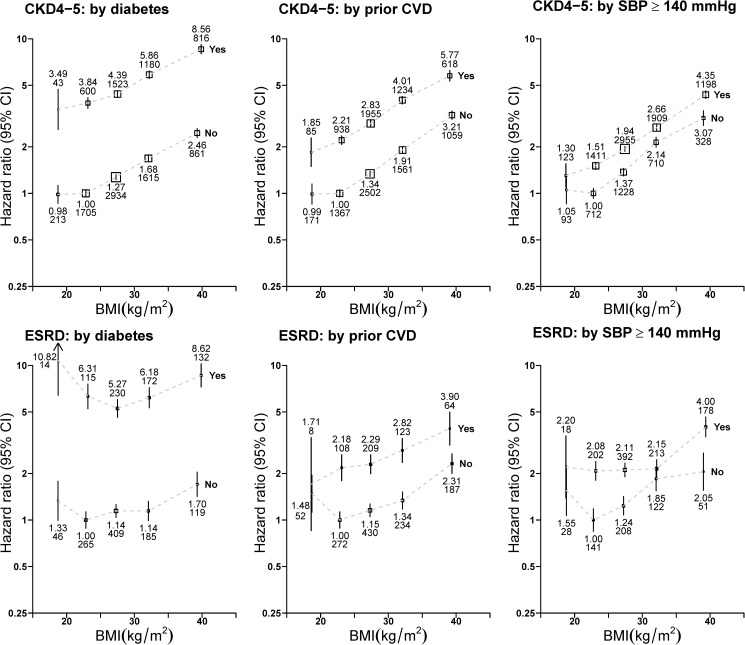
Association between baseline body-mass index and risk of advanced chronic kidney disease by diabetes, prior cardiovascular disease and uncontrolled hypertension at baseline.BMI = body-mass index. CKD4-5 = CKD stage 4 or 5. ESRD = end-stage renal disease. CVD = cardiovascular disease. SBP = systolic blood pressure. CI = confidence interval. Analyses excluded those with outcomes at baseline or during the first 3 years of follow−up. SBP analyses exclude 218,466 participants with a missing measurement. Hazard ratios were all adjusted or stratified by age (continuous), sex, current smoking and level of deprivation (by fifths) and are plotted against the mean BMI in each BMI category. Boxes are plotted so that the area is proportional to the inverse variance of the floated hazard ratio. Error bars indicate 95% CIs and are accompanied by the hazard ratio (upper number) and number of outcomes (lower number).